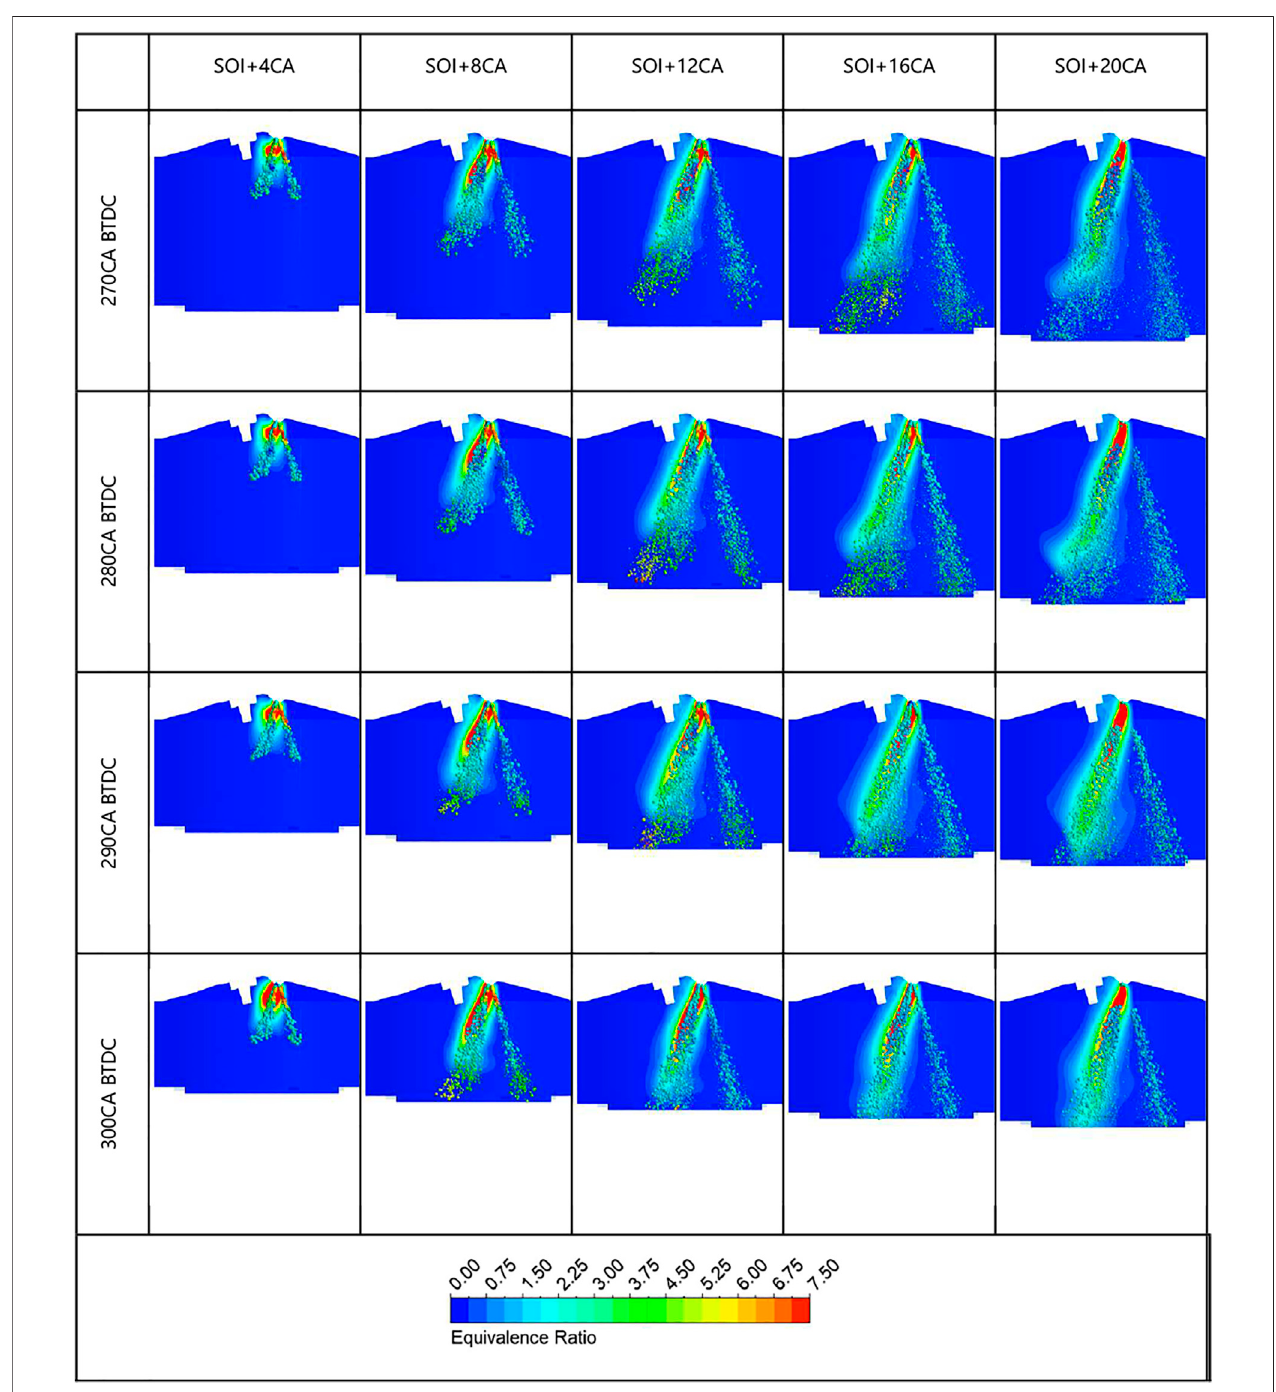
FIGURE 3 | Effect of injection timing on injection process at cylinder symmetry at several CA after SOI.